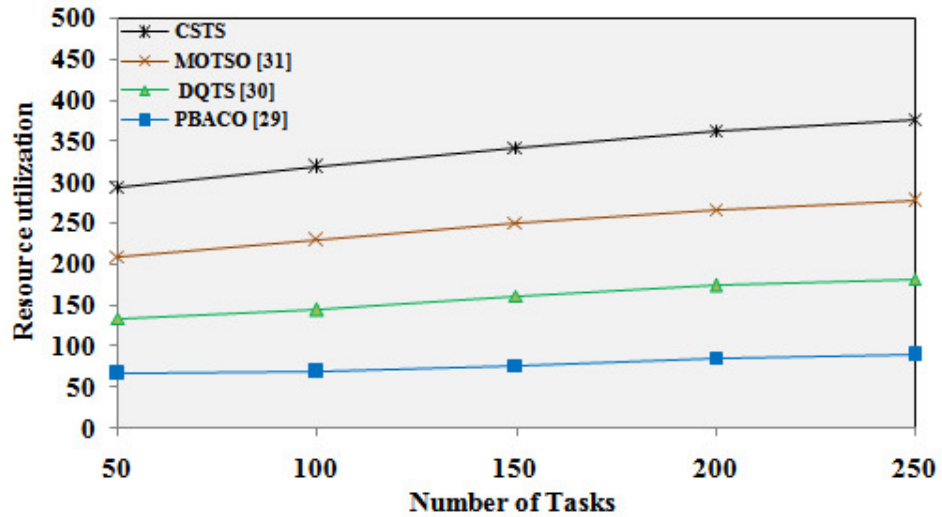
Figure 5. Resource utilization with number of